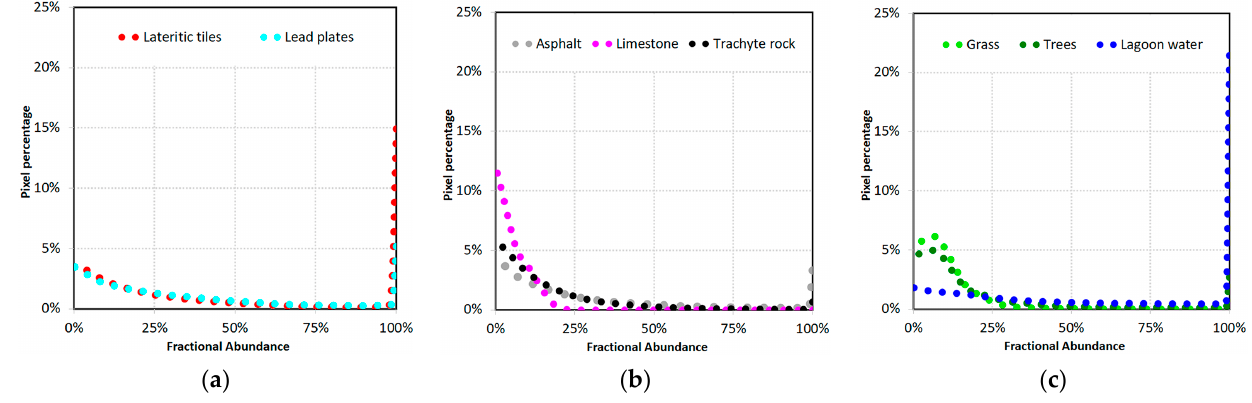
Figure 5. The histograms of fractional abundances obtained from the reference fractional abundance maps: ( a ) the histograms of lateritic tile and lead plate endmembers; ( b ) the histograms of asphalt, limestone, and trachyte rock endmembers; ( c ) the histograms of grass, tree, and lagoon water endmembers.